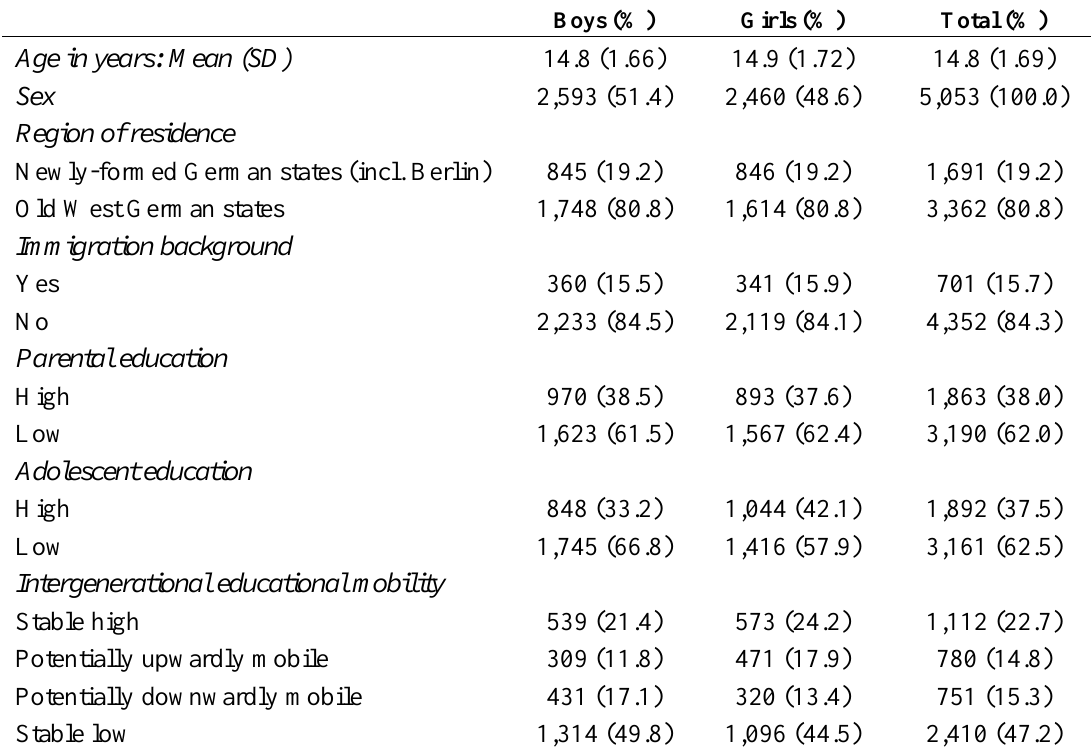
Table 1. Sociodemographic characteristics of the KiGGS sample (2003–2006) participants aged 12 to 17 years, by sex ( n = 5,053).